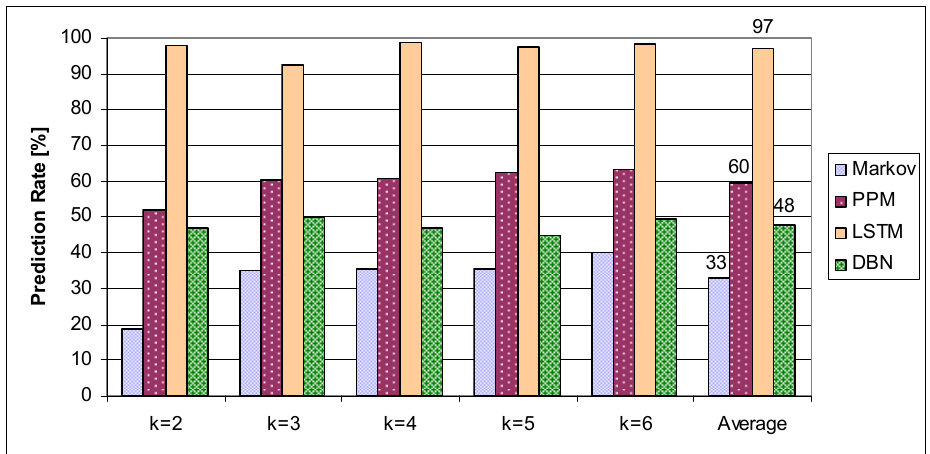
Figure 10. Prediction rate with the mood variable through k ‐ fold cross ‐ validation.